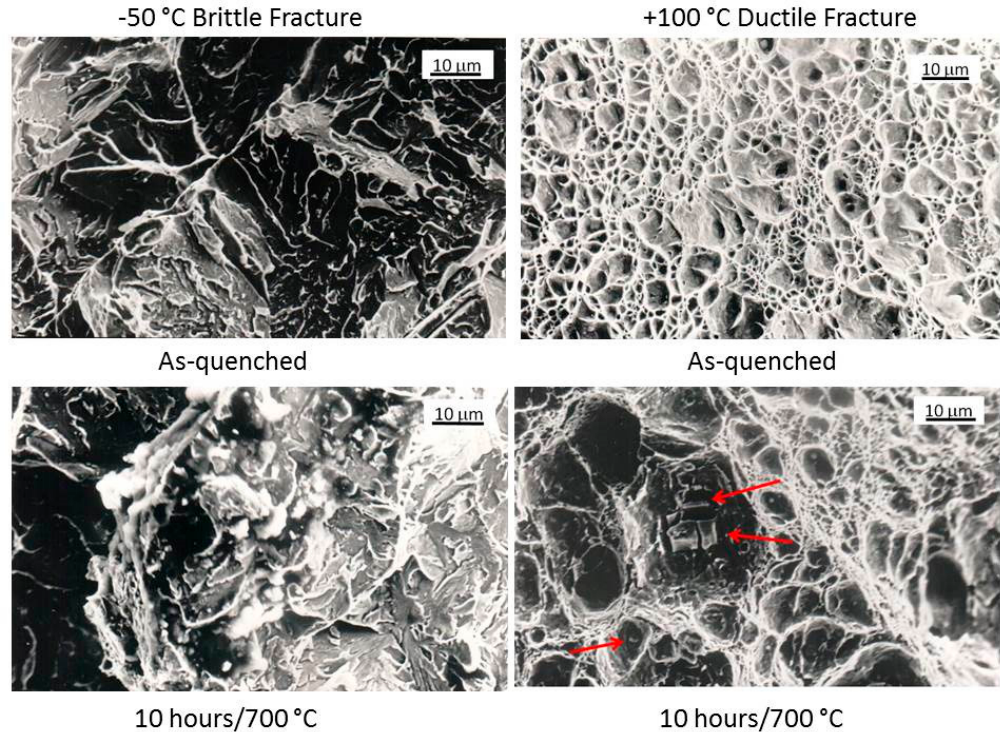
Figure 5. Fracture surfaces of the steel probes broken in Charpy tests in brittle ( − 50 °C) and ductile field (+ 100 °C).